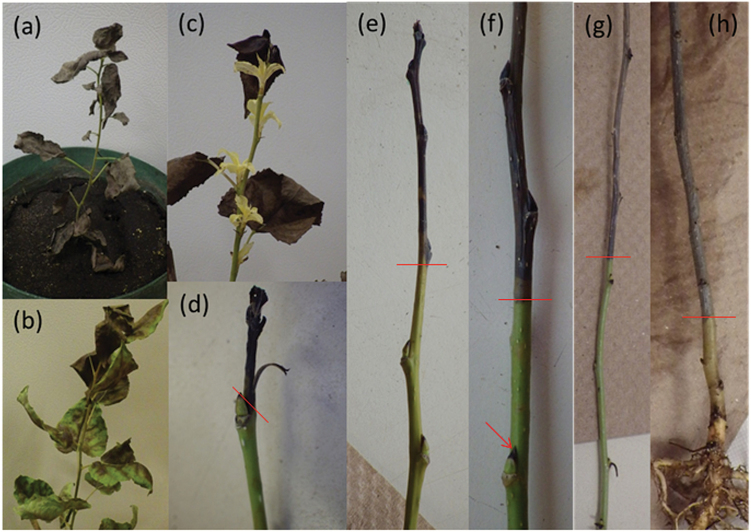
Above-ground tissue during starvation. (a) All leaf area is brown and dead. (b) All leaf area is dead, but some tissue is green but crisp. (c) Resprouting in the dark shortly after leaves have died. (d–h) Progression of stem dieback starting at the tip and proceeding downward to the base. Lines indicate the extent of necrosis. Note: green axillary buds are black-tipped (indicated by an arrow) and the root system in (h), after most of stem has died, appears to be still alive (i.e. not black).